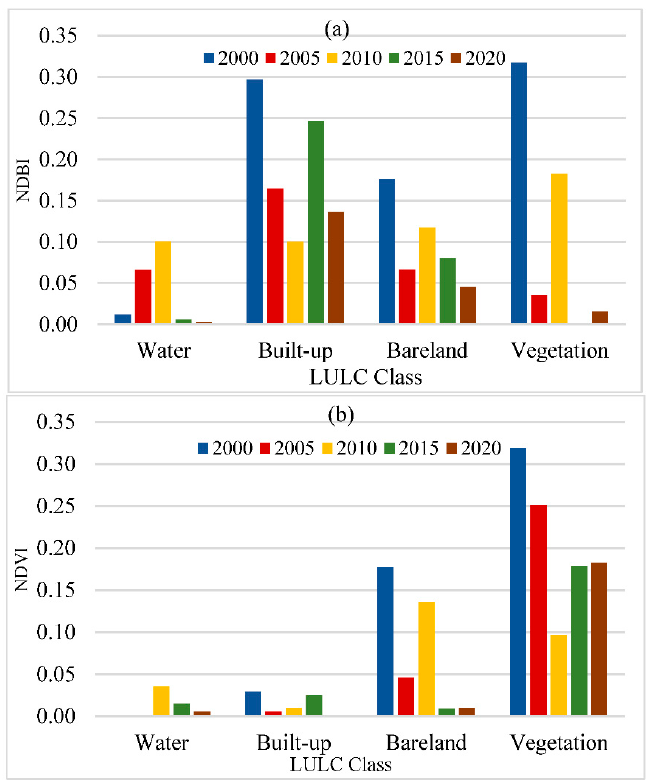
Figure 9. Relationship between the NLST and ( a ) NDVI and ( b ) NDBI, as given by the Pearson’s correlation coefficient value. Remote Sens. 2022 , 14 , x FOR PEER REVIEW